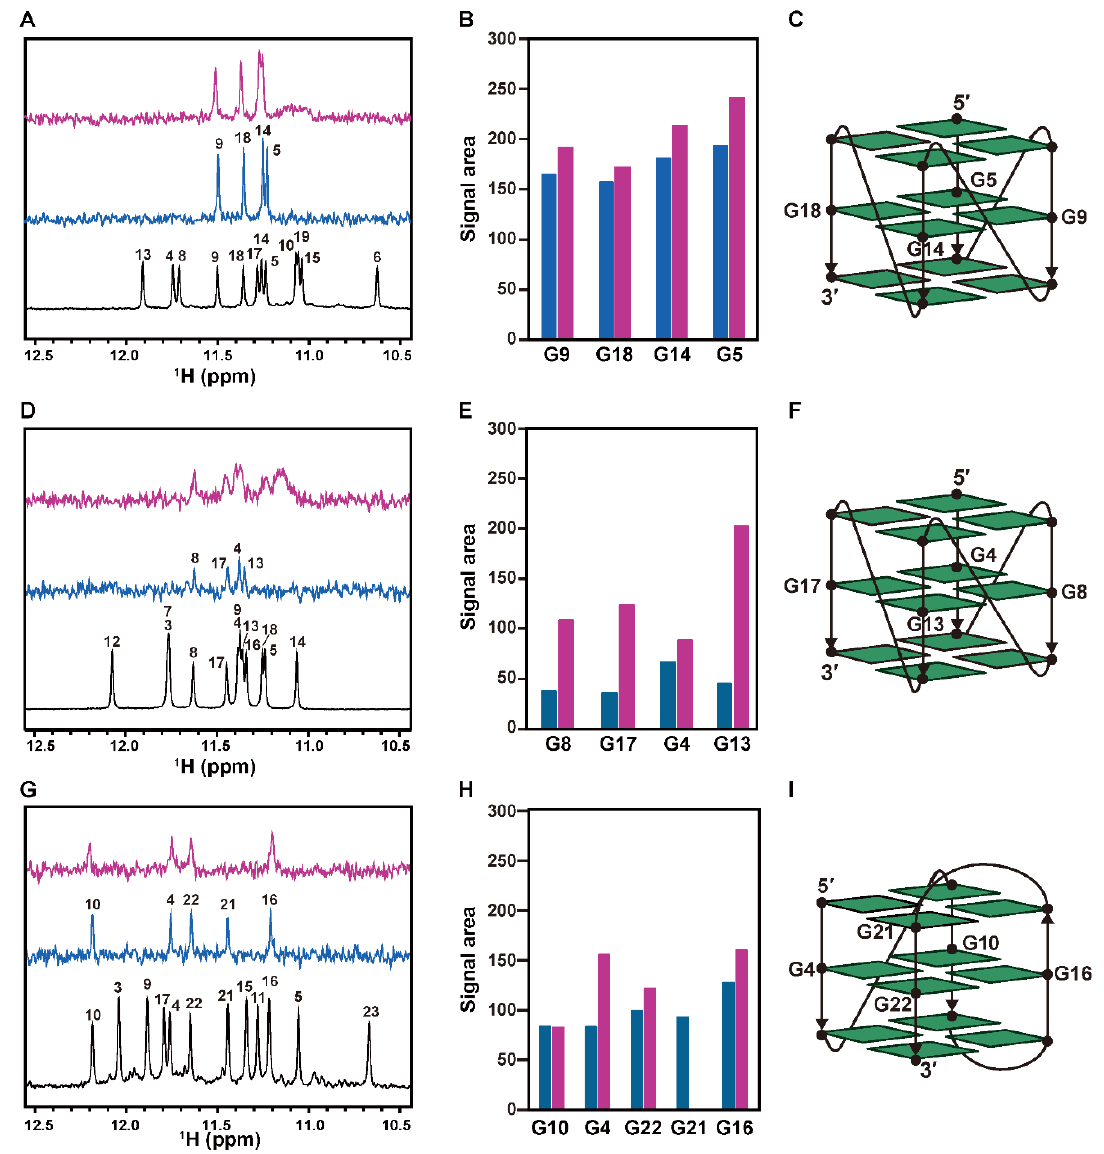
Figure 4. NMR-detected hydrogen-deuterium (H/D) exchange of imino protons of G-rich DNAs in a free form and a complex form with hORC1 413–511 . Imino proton signals of mtPu22 ( A ), mtPu19 ( D ), and teloDNA ( G ) in a free form in H 2 O (black) and 2 H 2 O (blue) solutions, and in a complex form with hORC1 413–511 in a 2 H 2 O solution (red) at pH 7.7 and 25 °C. The assignments were derived from references [30–32]. The spectra in the 2 H 2 O solution were recorded 1.5 h after dissolution of the lyophilized sample in the 2 H 2 O solution. The signal areas were calculated for mtPu22 ( B ), mtPu19 ( E ), and teloDNA ( H ) in the free (blue) and complex (red) forms. A schematic illustration of each structure is shown for mtPu22 ( C ), mtPu19 ( F ), and teloDNA ( I ).